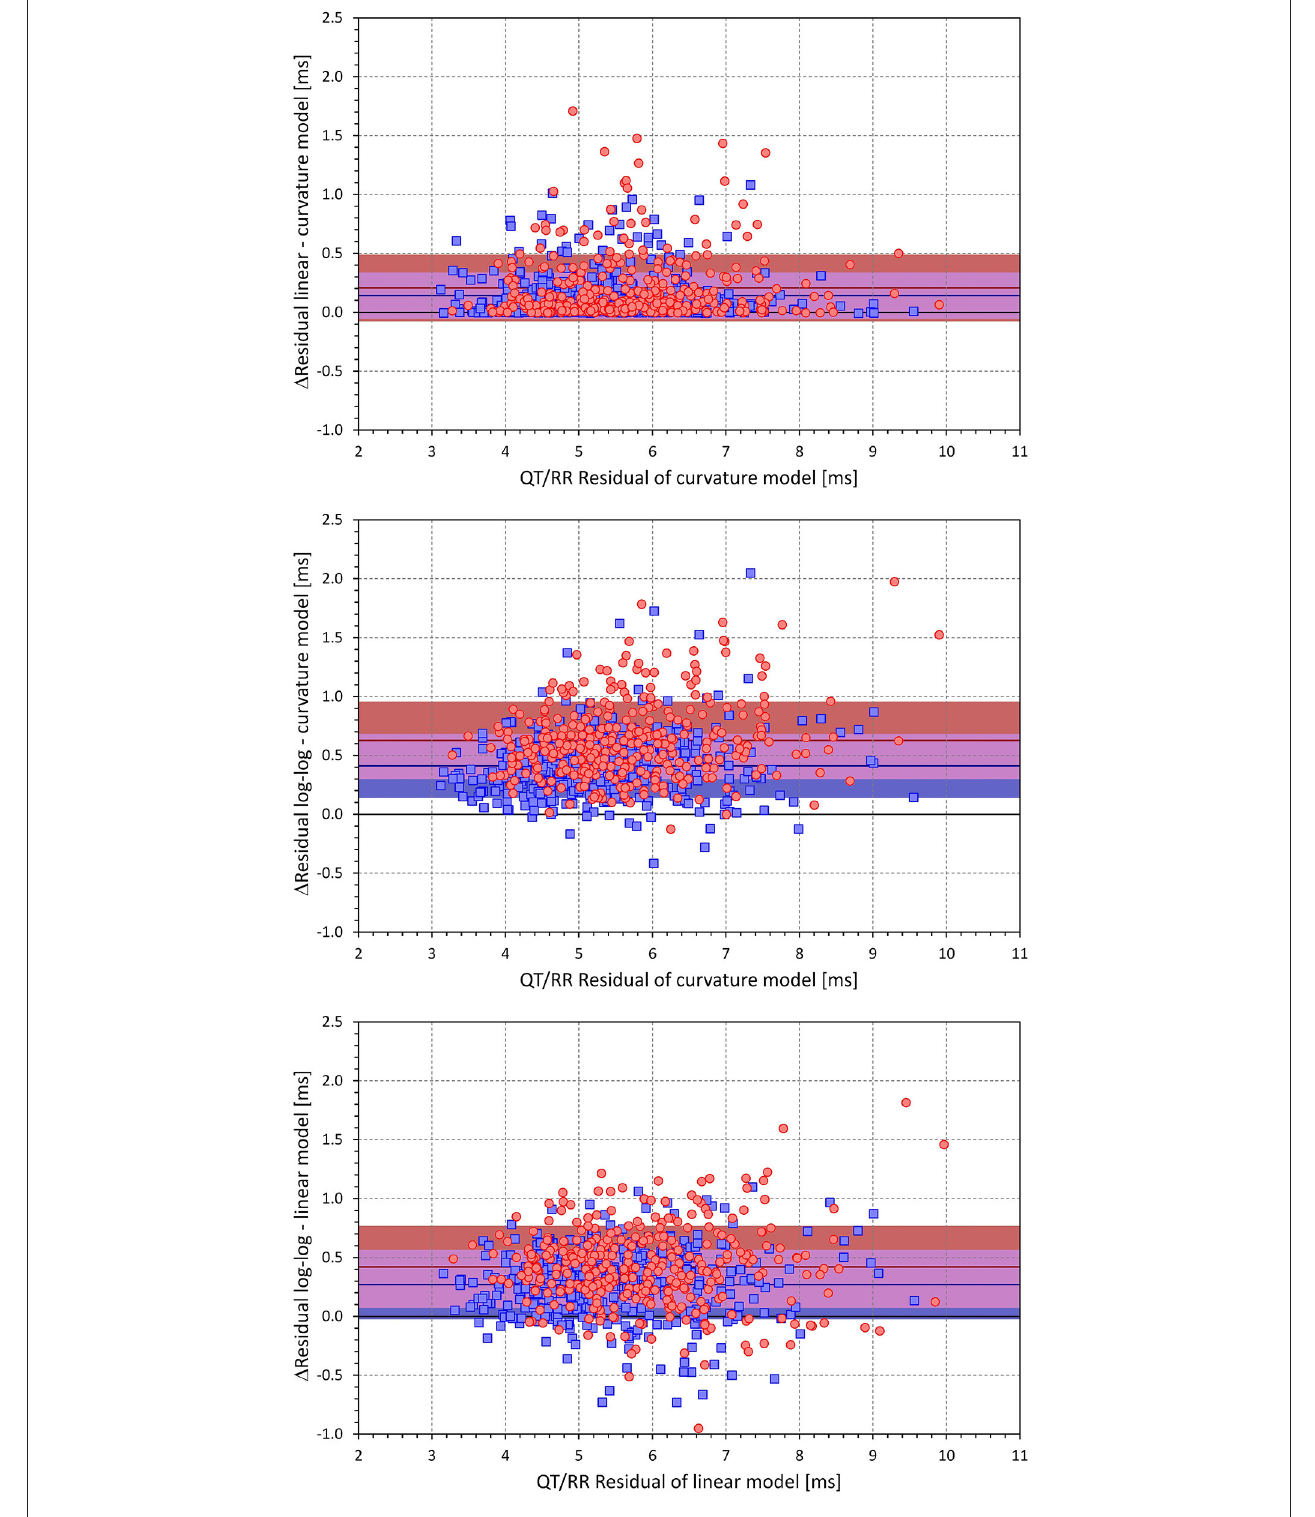
FIGURE 4 | Scatter diagrams of the intra-individual differences among the different QT/RR H regression models (all combined with the time-based QT/RR hysteresis model). The top panel shows the differences between the residuals of the linear and curvature models and the residuals of the curvature model, the middle